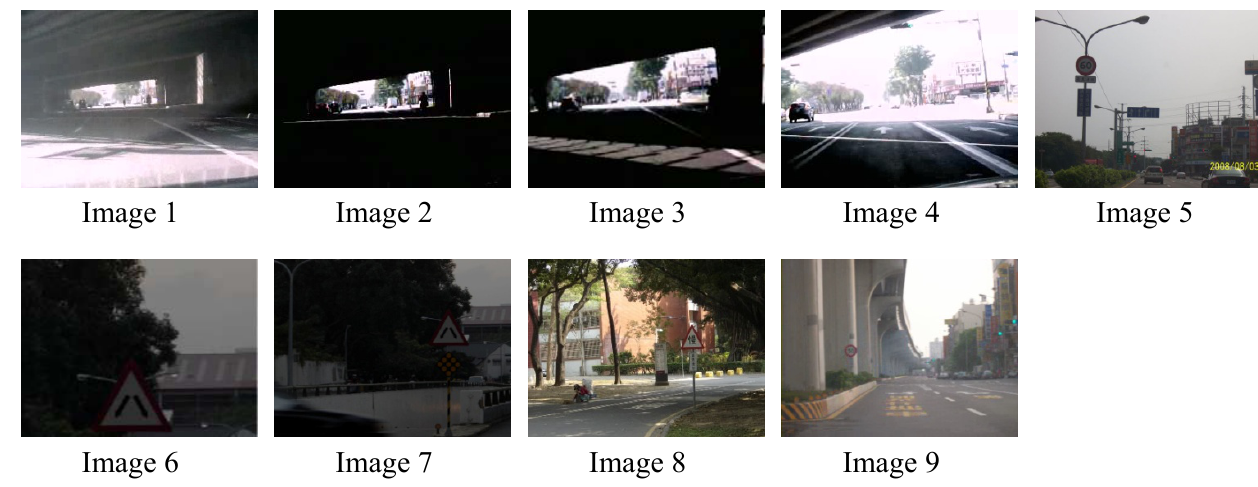
value curves of the nine testing images μ